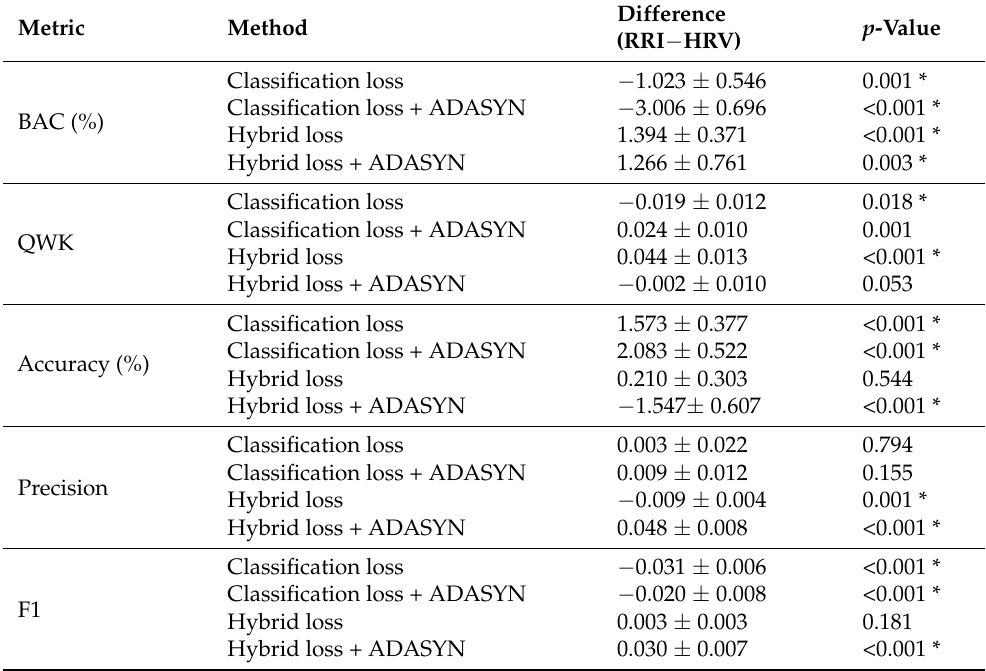
Table 8. Mean and 95% CI of difference in performance metrics between the RRI and HRV models. The differences were calculated by subtracting the value of an HRV model from that of an RRI model. A two-sample t -test was performed to compare the metrics from the two models (* p <